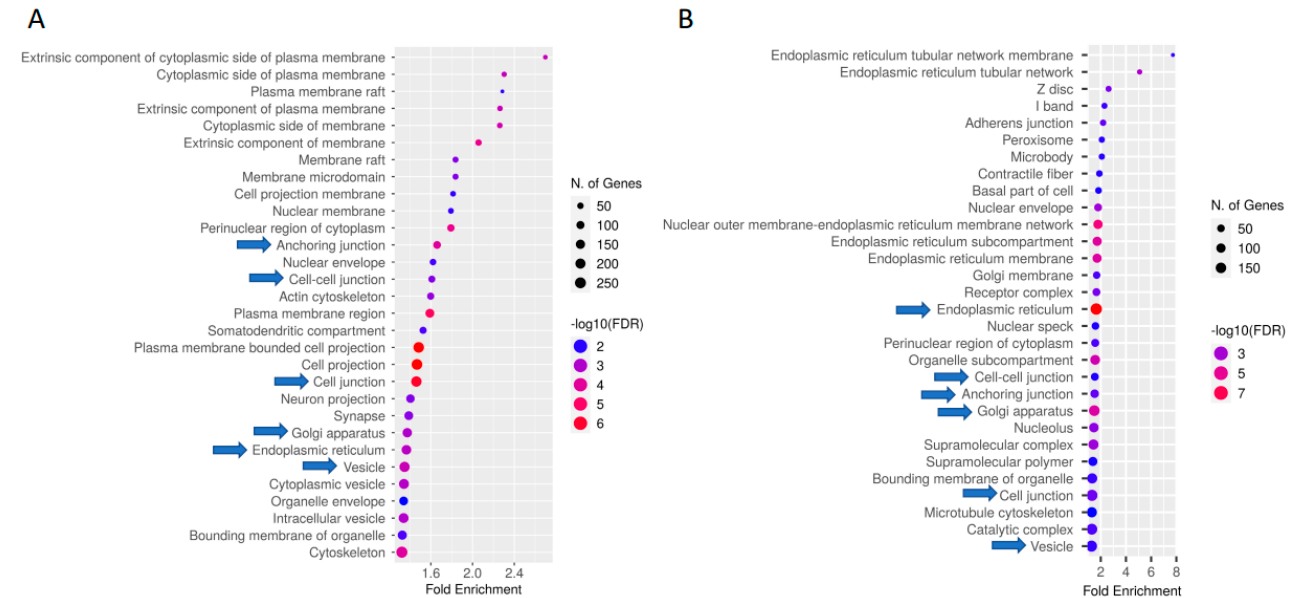
Figure 2. GO enrichment results for the induced ( A ) and repressed ( B ) differentially CTCF-binding sites after weaning. The top 30 hits of GO terms are shown in this figure. Biological processes are ranked according to the fold enrichment values. Bubble colors represent the p -value of the False Discovery Rate (FDR). The most significant processes are highlighted in red, and the less significant processes are highlighted in blue according to log 10 (FDR) values. Bubble sizes indicate the number of genes. Blue arrows indicate GO terms present in both induced and repressed sites.